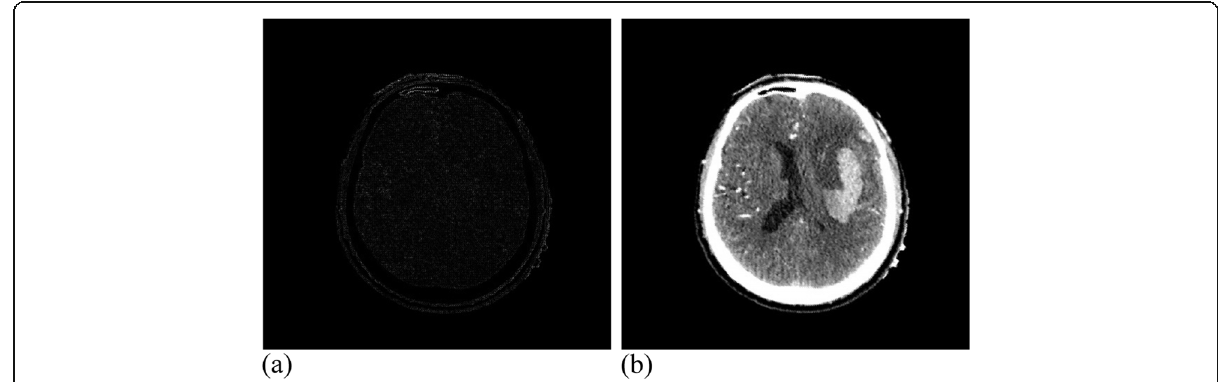
Fig. 13 CT data after registration. (a) : Difference between CT reference image and registration image; ( b ): CT registration image